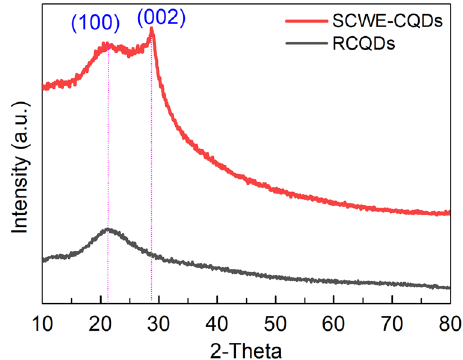
Figure 3: XRD di ff raction patterns of RCQDs and SCWE -